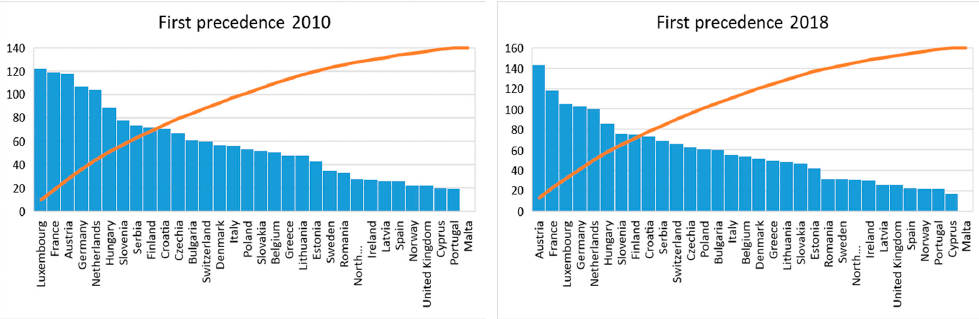
Figure 5. Number of the first precedencies by country in 2010 and 2018—geospatial distribution.